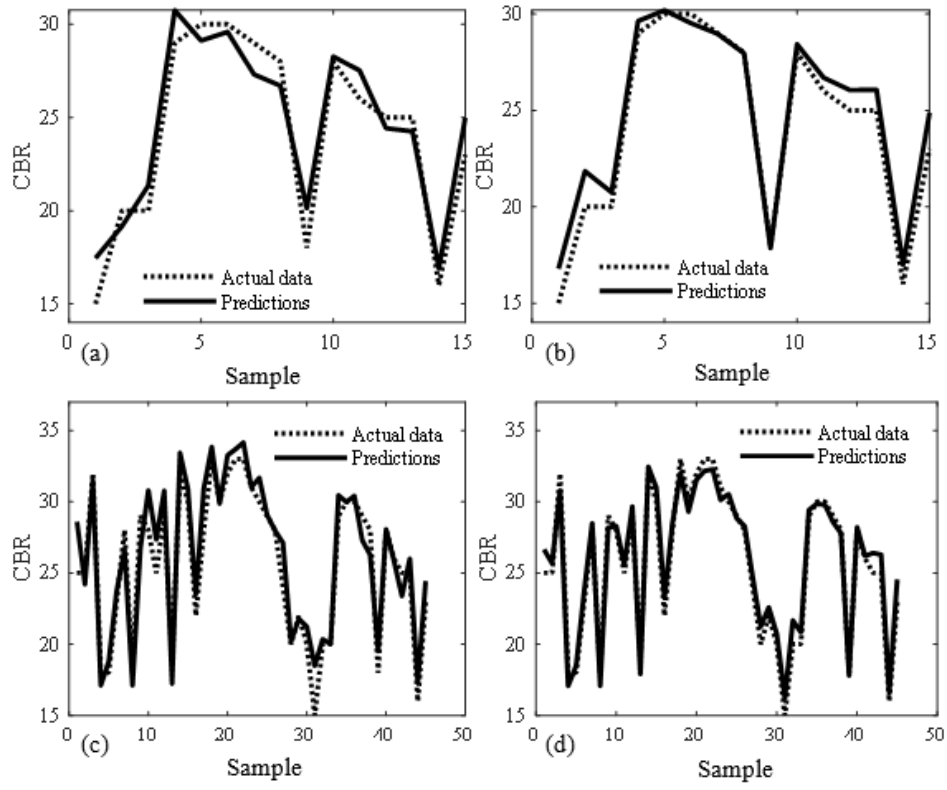
Figure 6. Predicted CBR values vs. actual ( a ) ELM model with 90% training, ( b ) ELM-CSO with 90% training, ( c ) ELM model with 70% training, ( d ) ELM-CSO model with 70% training.